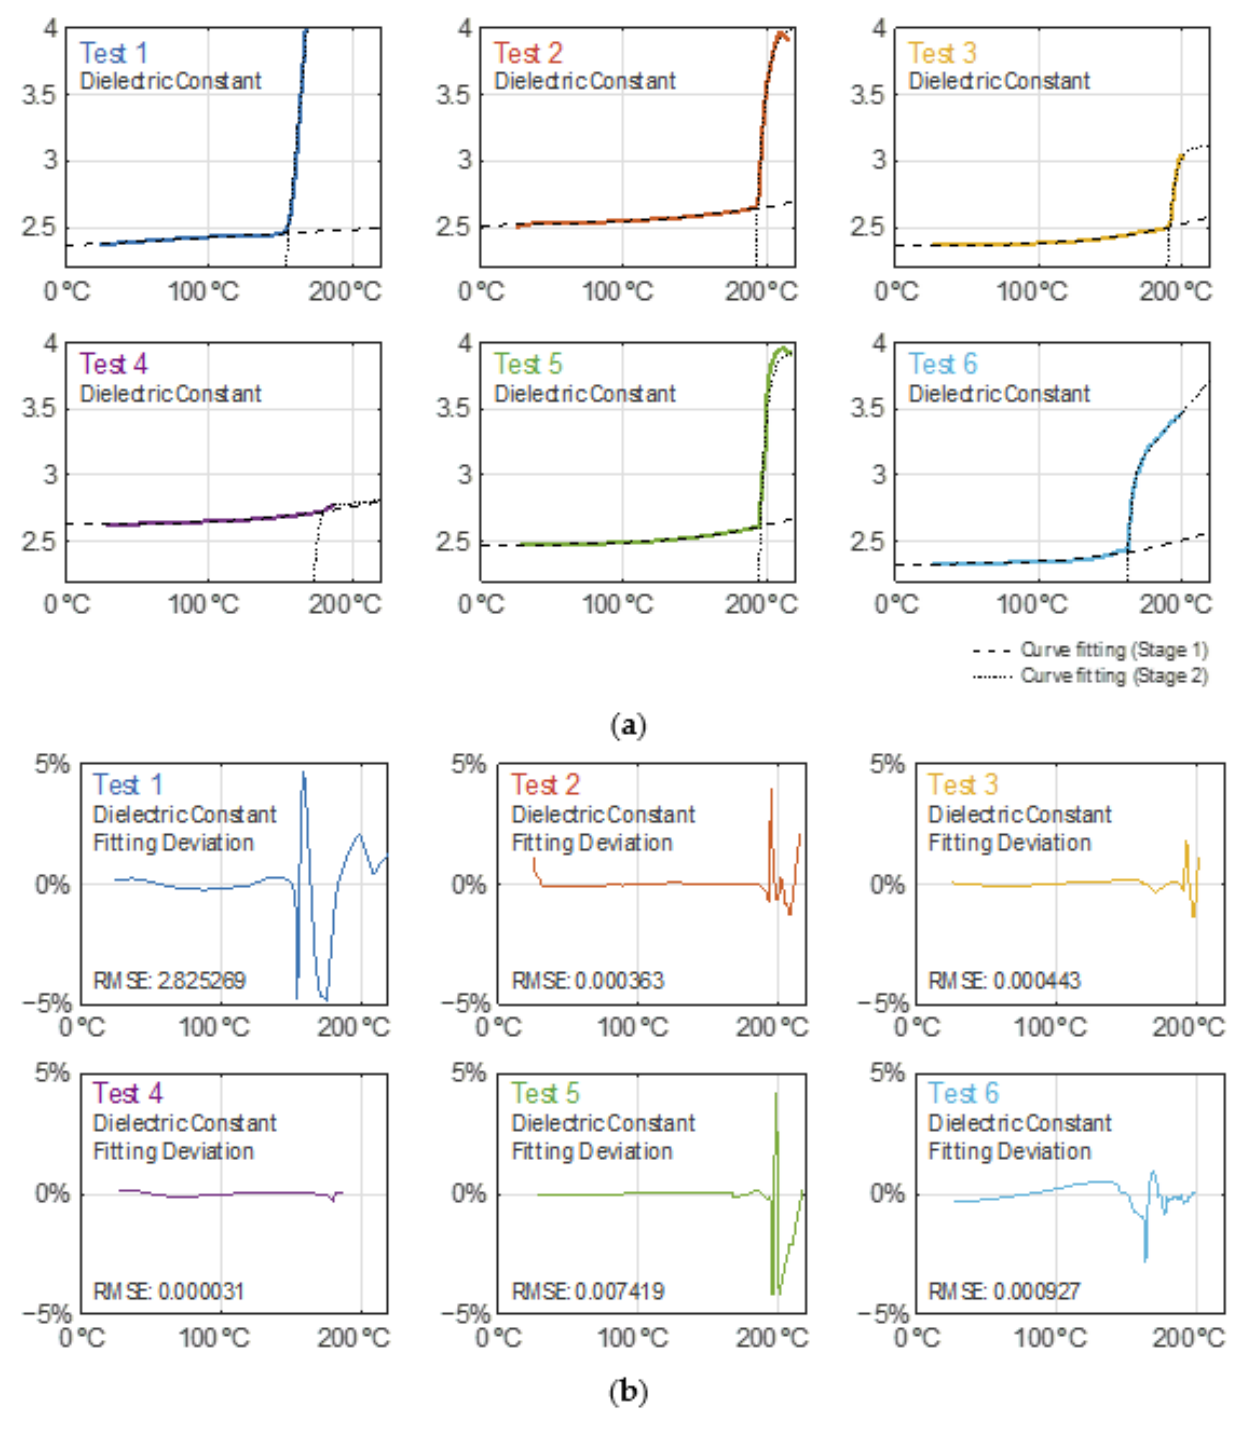
Figure 7. ( a ) Dielectric constant behavior during the heating and curve fitting modelling for each test. ( b ) Dielectric constant curve modelling relative residuals for each